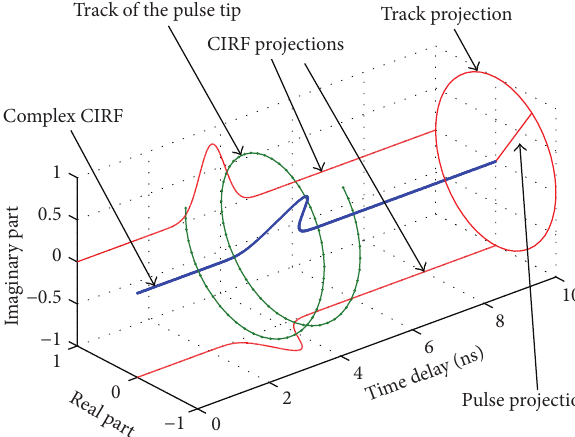
Figure 5: The complex CIRF of a variable